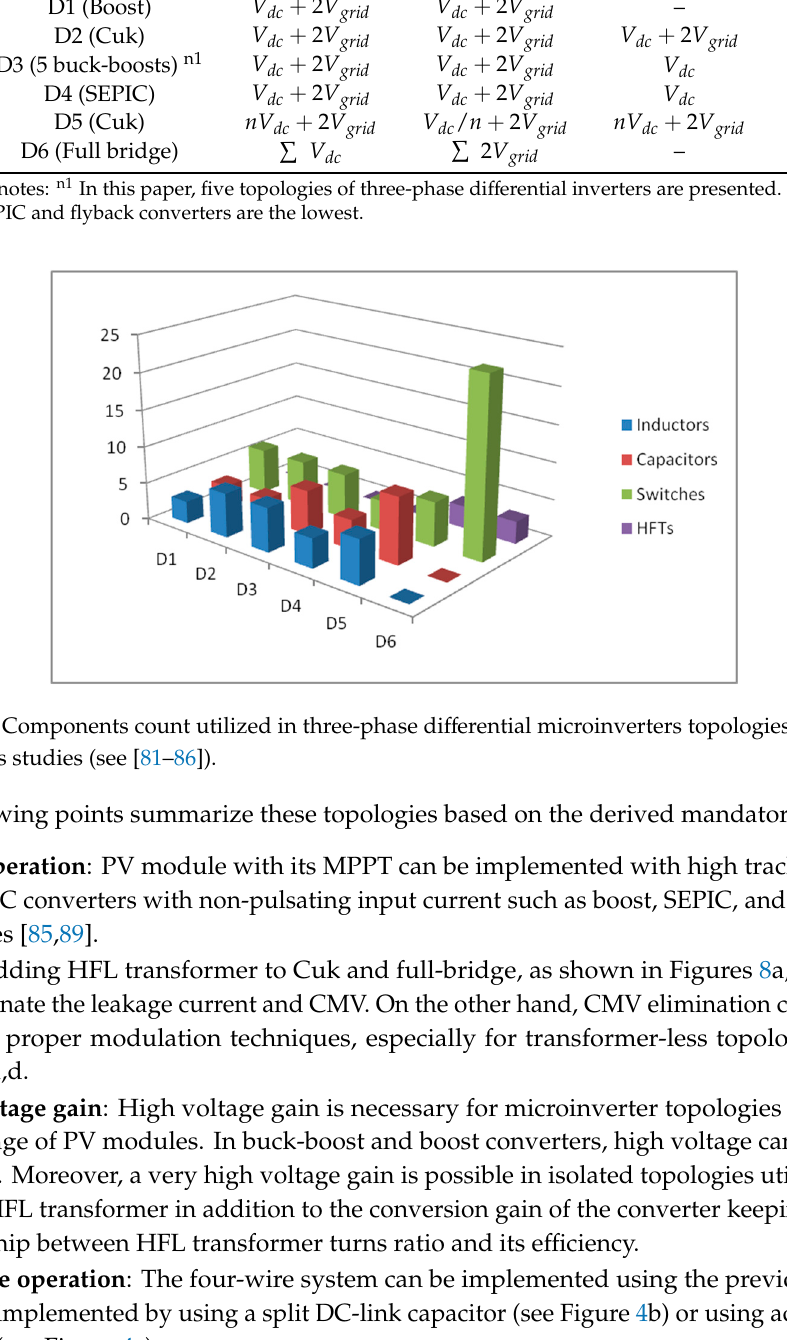
Figure 11. Classical Z-source inverter [94,95].